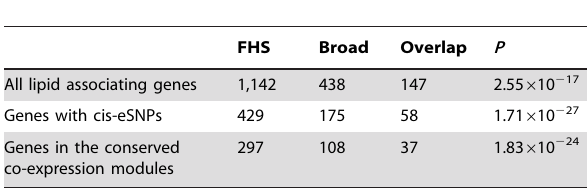
Table 3. Conserved modules and cis eSNPs can help elucidate common candidate genes from GWAS